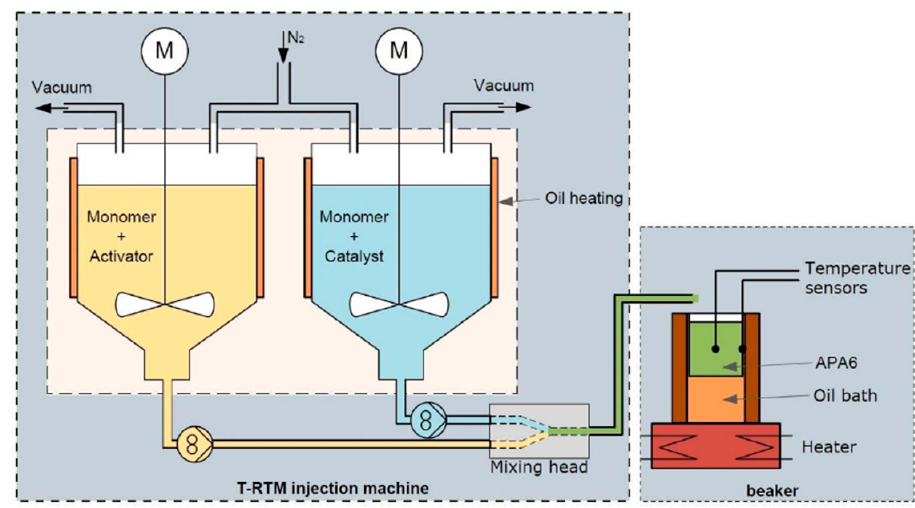
Figure 1. Schematic setup of low pressure T-RTM injection machine and beaker for the kinetic tests.